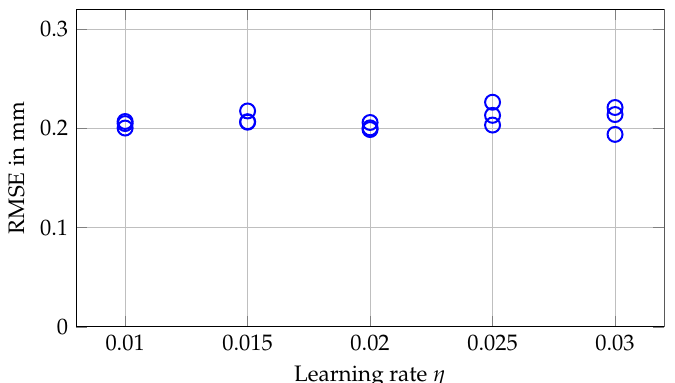
Figure 8. RMSEs for translational motion along all three axes. Three repetitions are shown for each learning rate η . Each time, the robot arm drove back and forth along a diagonal line within a cube with side length 8mm at a velocity of 12mm/s.